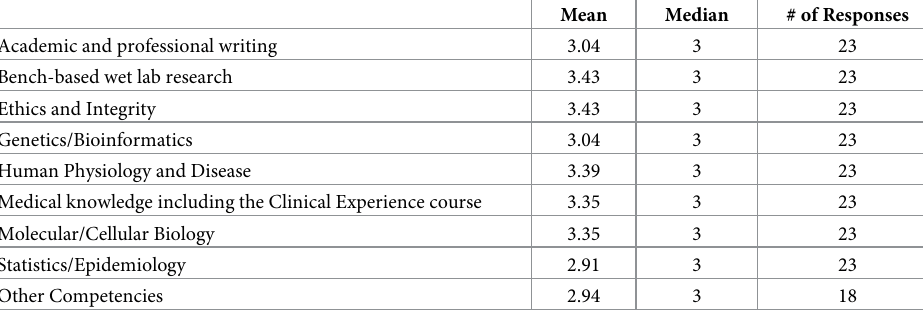
Table 6. Satisfaction with competency